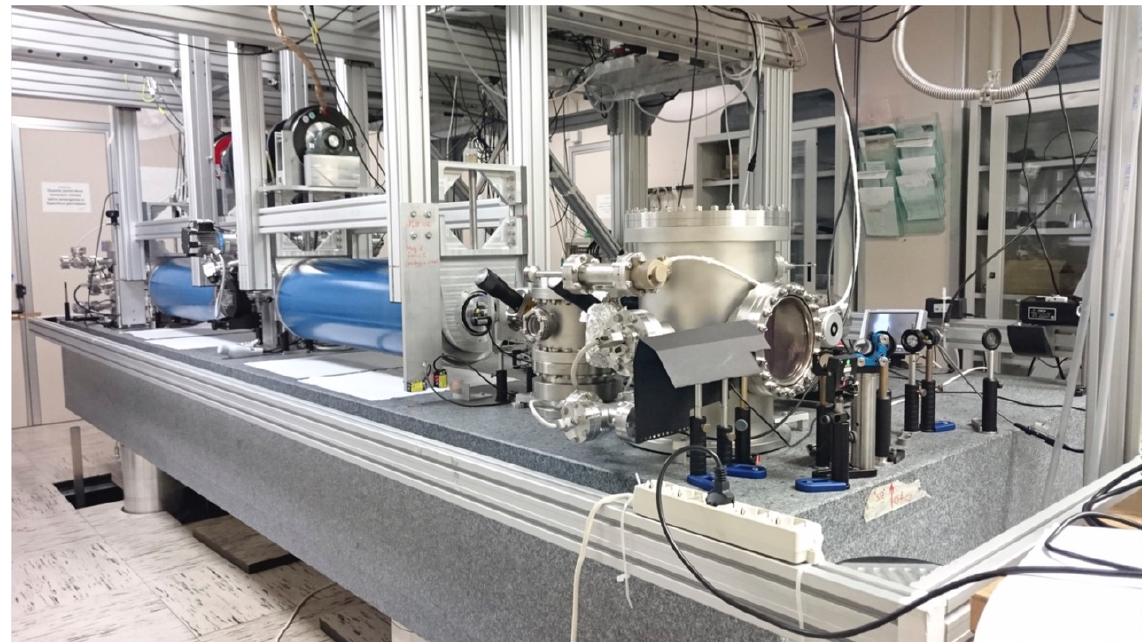
Figure 11. Photograph of the optical bench layout of the PVLAS-FE apparatus installed at the Department of Physics and Earth Sciences of the University of Ferrara and INFN Section of Ferrara, Ferrara, in